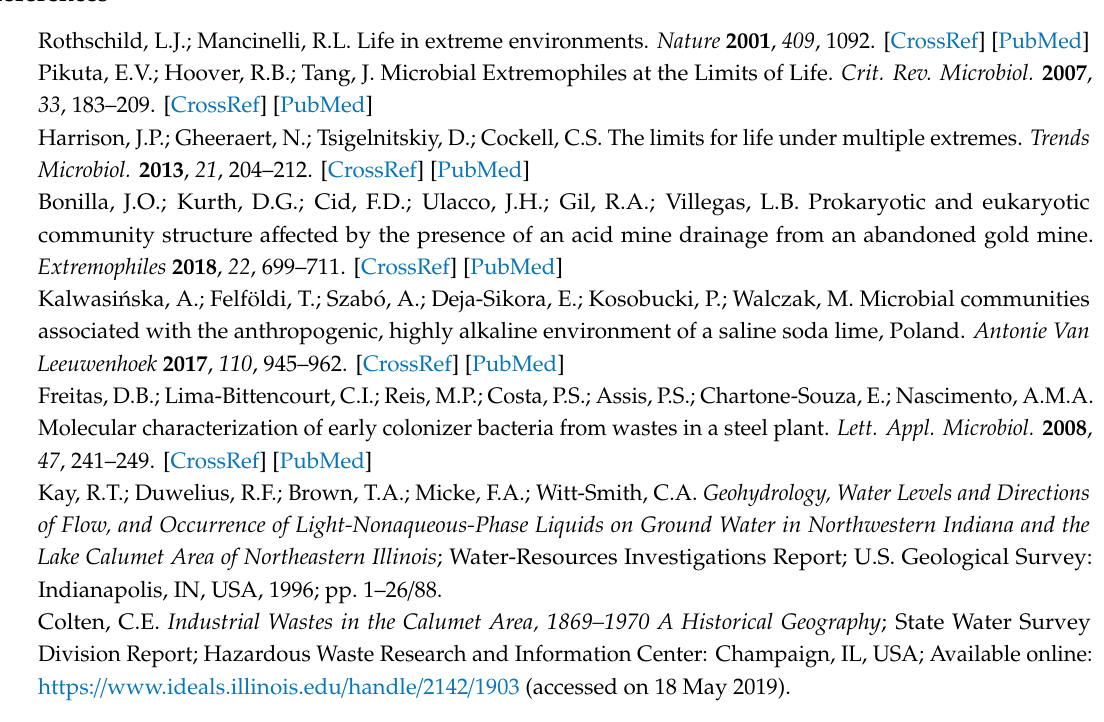
Figure S1: Phylum- and Proteobacterial class-level 16S rRNA gene relative abundances from water samples at sites 4, 5 and 7; Figure S2: Rarefaction curves for all datasets. Rarefaction for samples using RDP OTUs at the genus level using 1000 replicates; Figure S3: Analysis of similarities (ANOSIM) plot of Calumet sites, grouped by physical condition of samples. Non-overlapping notches suggest medians are distinct. Dissimilarity between groups is relatively high, and Oxic Alkaline ( Serpentinomonas -rich) samples have low internal dissimilarity; Table S1: Field Sample Information, Table S2: Class-level 16S rRNA gene relative abundances from water